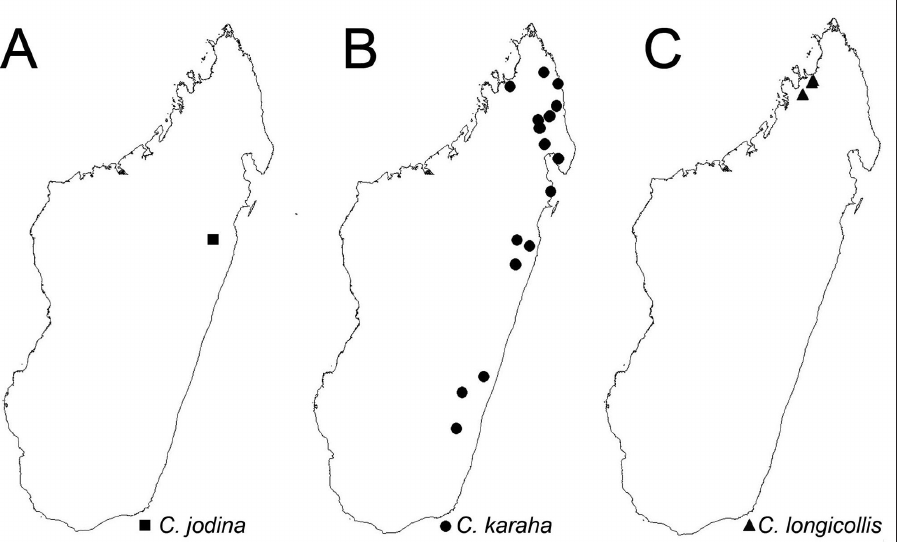
Figure 18. Distribution maps of the three new species. A Camponotus jodina B Camponotus karaha C Camponotus